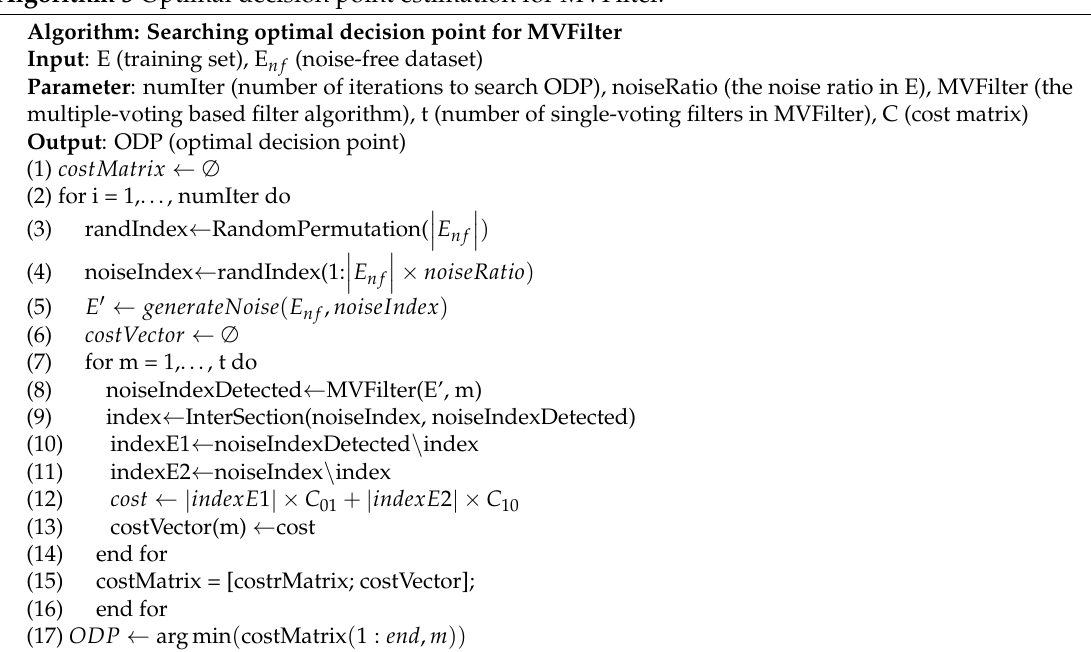
Algorithm 3 Optimal decision point estimation for MVFilter. Algorithm: Searching optimal decision point for